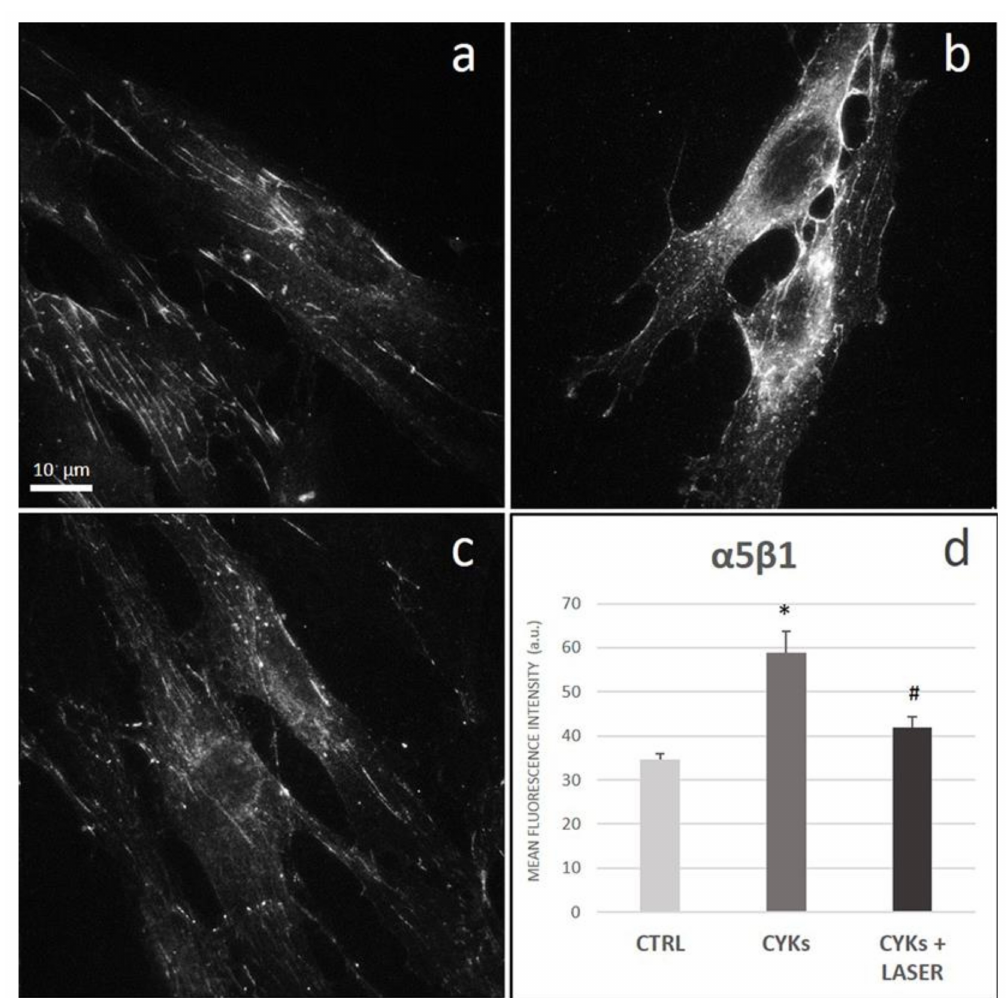
Figure 6. Effect of laser treatment on α 5 β 1 expression and distribution. Microscopy analysis of α 5 β 1 expression evaluated by immunofluorescence (magnification 100 × ) on NHDF in basal conditions (CTRL; panel ( a )), stimulated with IL-1 β and TNF- α for 48 h (CYKs; panel ( b )), stimulated with IL-1 β and TNF- α for 48 h and then exposed to laser treatments (3 treatments, repeated once a day, for 3 consecutive days) (CYKs + Laser; panel ( c )). Bar = 10 µ m. The histogram reports the mean pixel intensity, acquired by ImageJ software after appropriate thresholding and subsequent image masking (panel ( d )). * p < 0.05 CYKs group vs. CTRL group; # p < 0.05 CYKs + Laser group vs. CYKs group ( n =